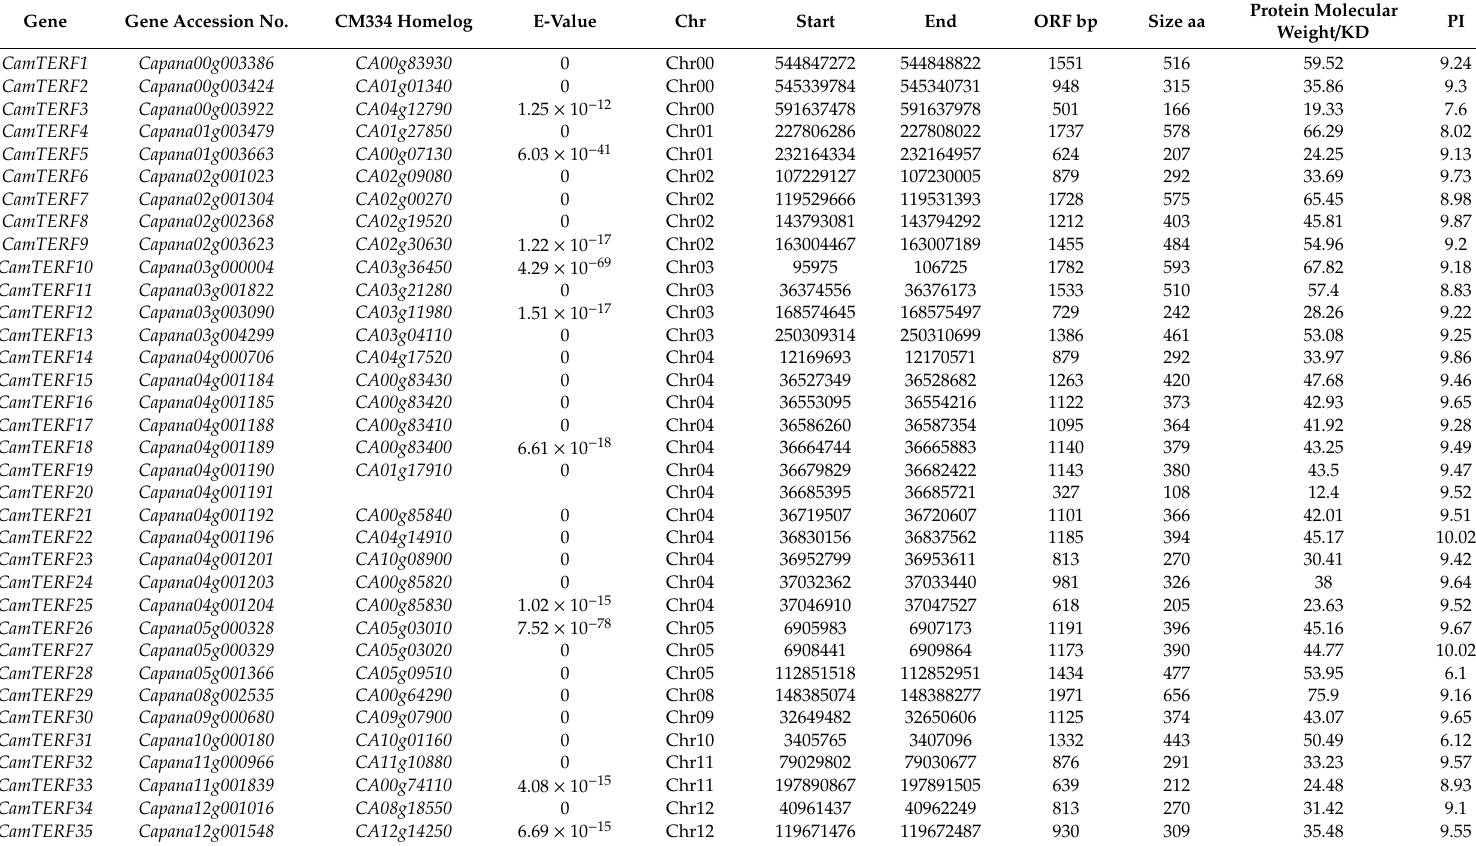
Table 1. The basic information of the mitochondrial transcription termination factor ( mTERF) gene family in capsicum. List of predicted genes and related information include gene name (Zunla_1), CM334 homologous gene and E-value, gene locus, molecular details.